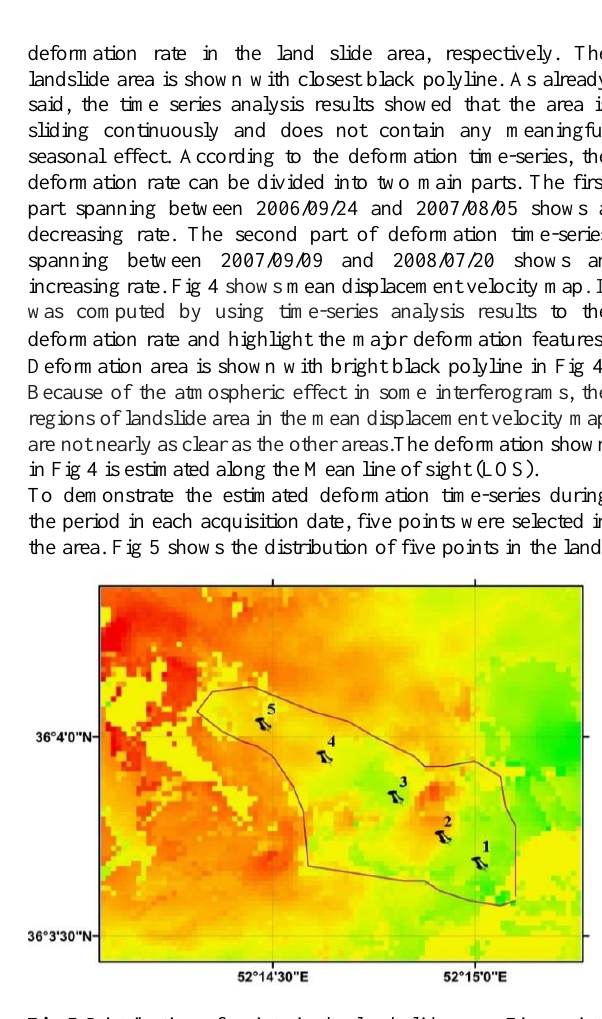
Fig 5 Distribution of points in the land-slide area. Five points are selected in the land-slide area. Black polyline shows the landslide boundary.